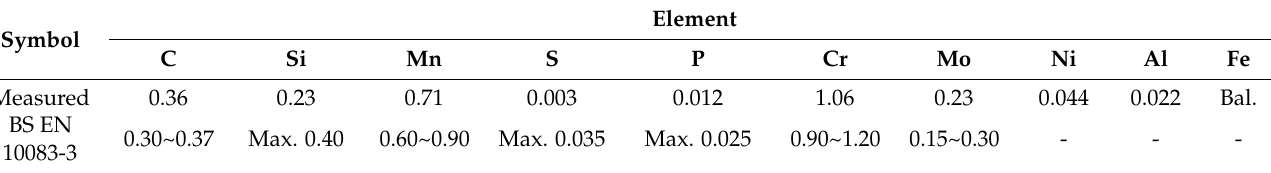
Table 1. The chemical composition of 34CrMo4 steel (%, mass